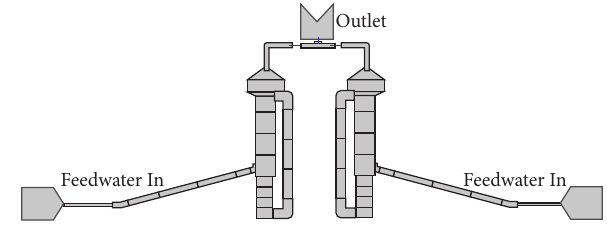
Figure 12: Thermal-hydraulic nodalization of the RD-14M secondary